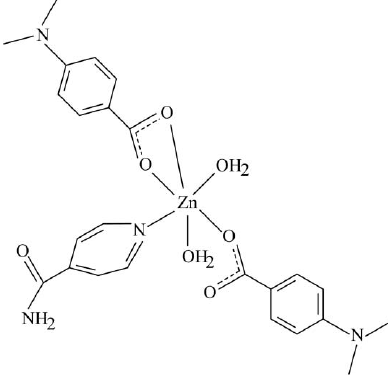
Experimental Crystal data